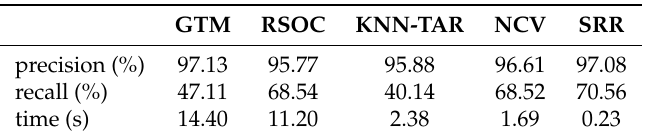
Table 2. The performance comparison using different algorithms. GTM: Graph Transformation Matching; RSOC: Restricted Spatial Order Constraints; TAR: triangle-area representation; KNN: K -nearest neighbors; NCV: neighborhood coding and